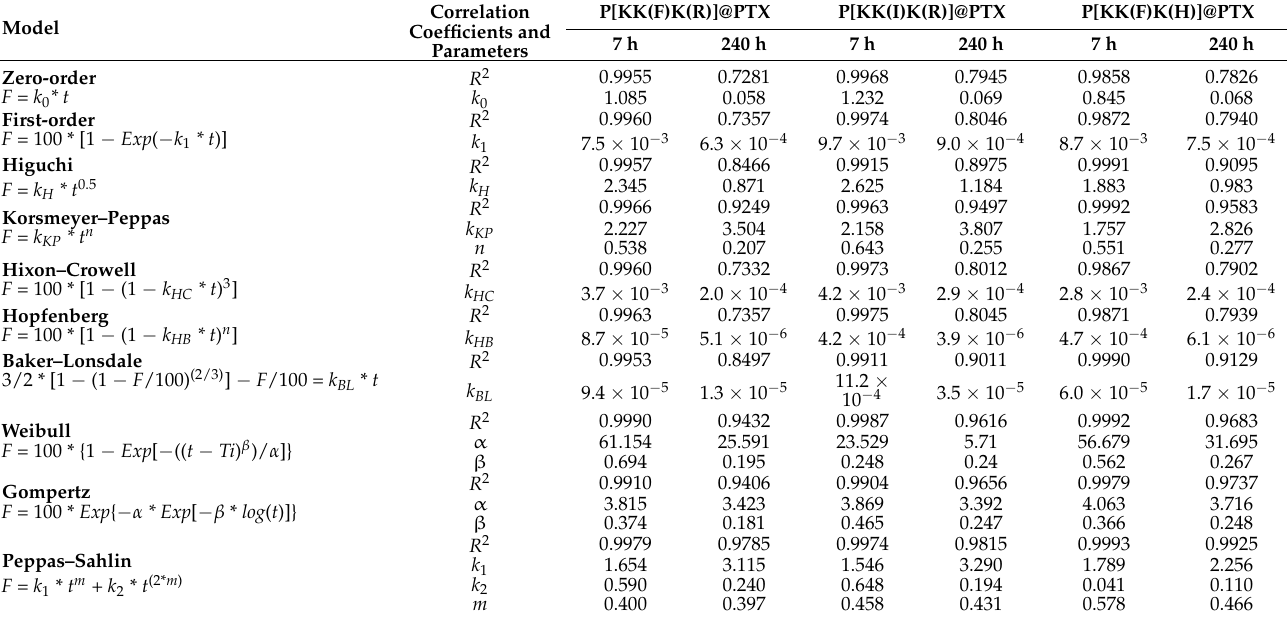
Table 3. Correlation coefficients and dissolution model parameters obtained by mathematical mod- elling of PTX release from various PP@PTX systems.